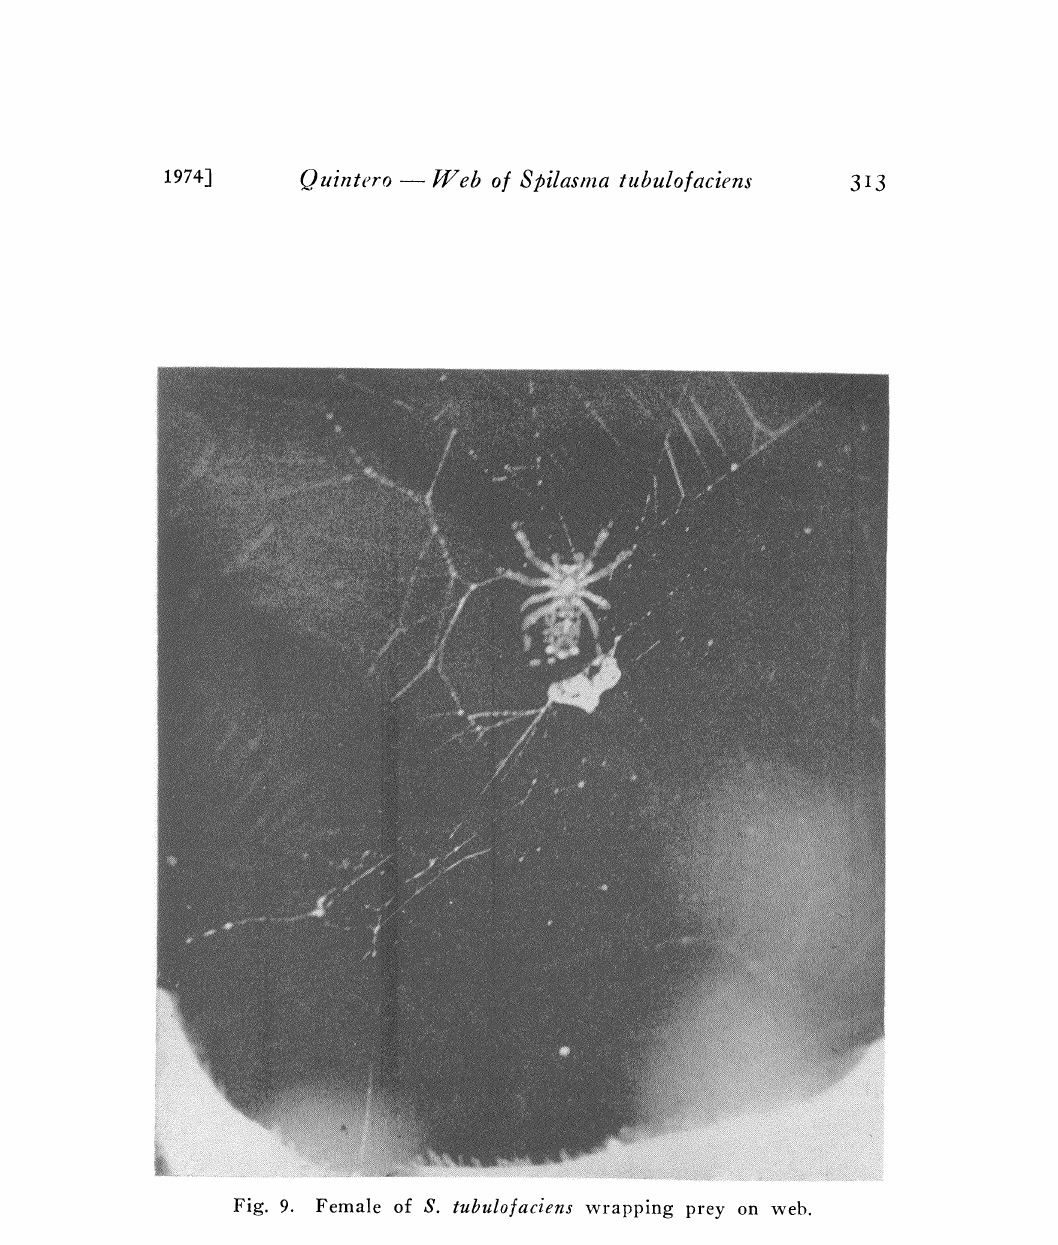
Fig. 9. Female of S. tubulofaciens wrapping prey on